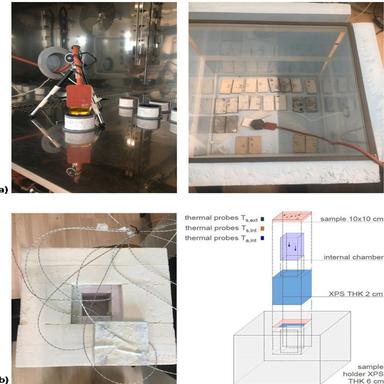
a) Hot Disk investigation of the composites (left) and the panels (right) and b) position of thermal probes during the thermal monitoring of the panels.